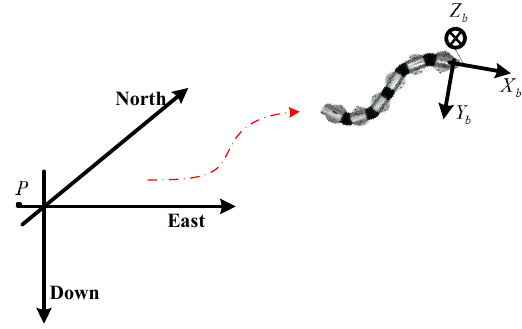
Figure 1. Navigation coordinate system of the snake robot.